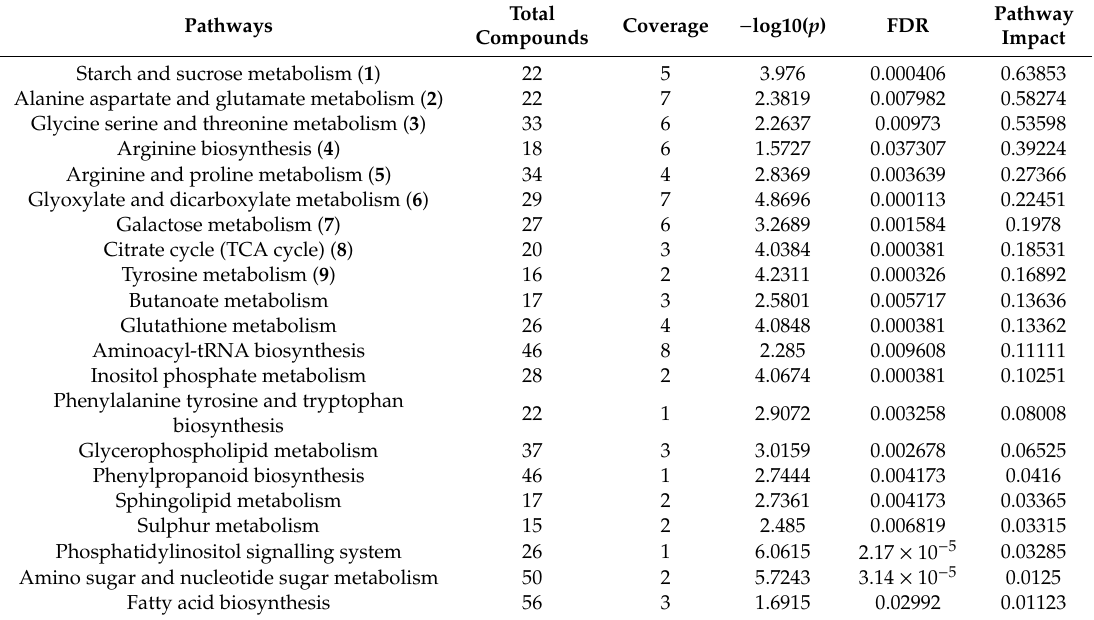
Table 2. KEGG-based metabolomic pathway enrichment and topology analysis for GC-MS derived metabolomics data, obtained from Arabidopsis roots treated with nerolidol 120 µ M for 14 d. Metabolites were analyzed through the MetaboAnalyst tool for KEGG-based “ Pathway Analysis ”. Full data are reported in Table S3. n =